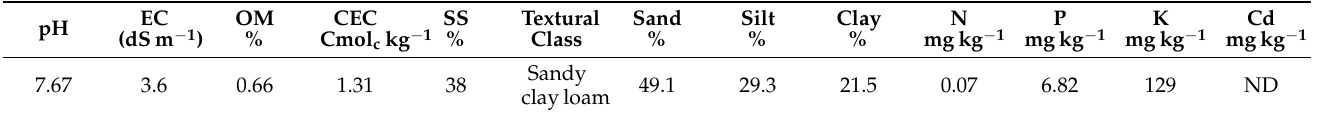
Table 2. Physico-chemical properties of potted soil.